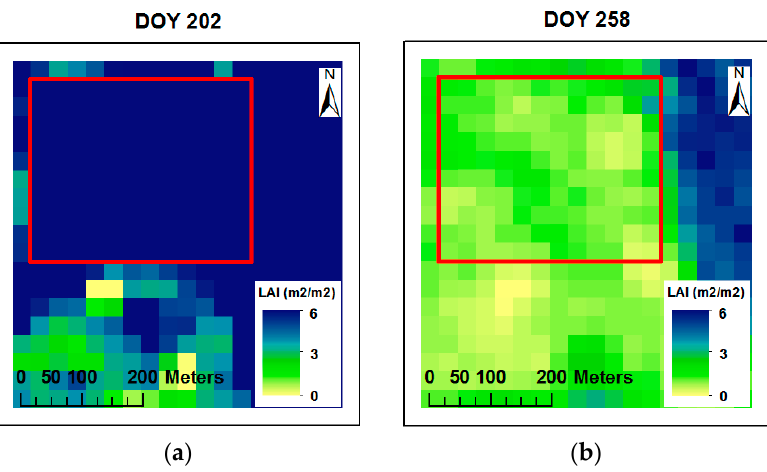
Figure 4. Spatial and temporal LAI maps developed from the METRIC model for two overpass dates (DOY 202 and DOY 258). The red rectangle indicates the area of interest within the corn field.